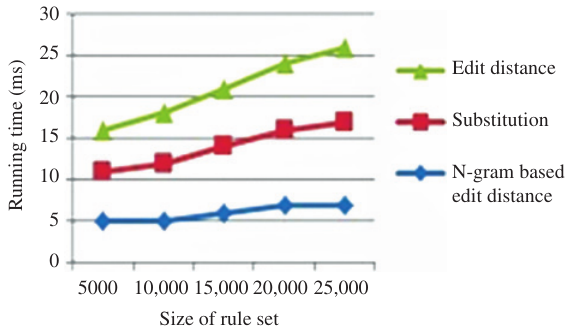
Figure 8: Effects of Size of Rule Set in Various Methods.